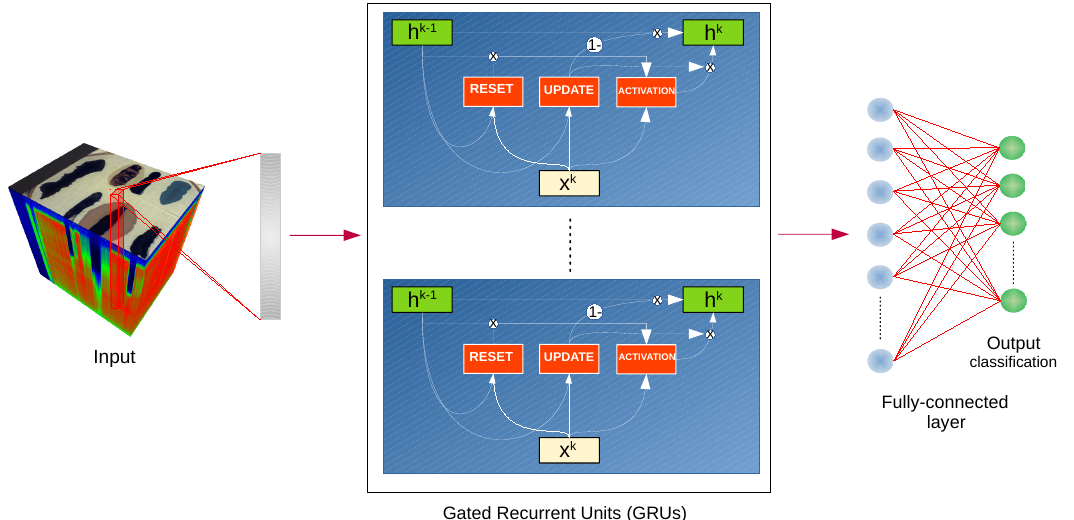
Figure 3. Schematic of the RNN architecture [14] used in experiments, we denote the value of k-th spectral band as x k and the hidden state of the previous and the current step as h k − 1 and h k ,